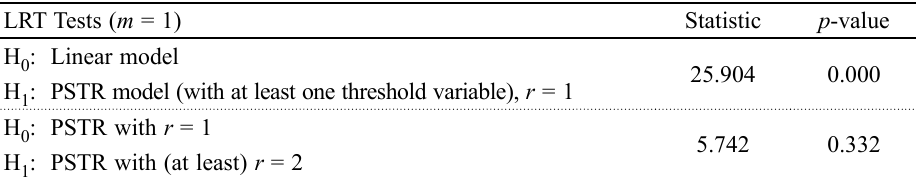
Table 5. Empirical results of the homogeneity tests for medium-sized banks